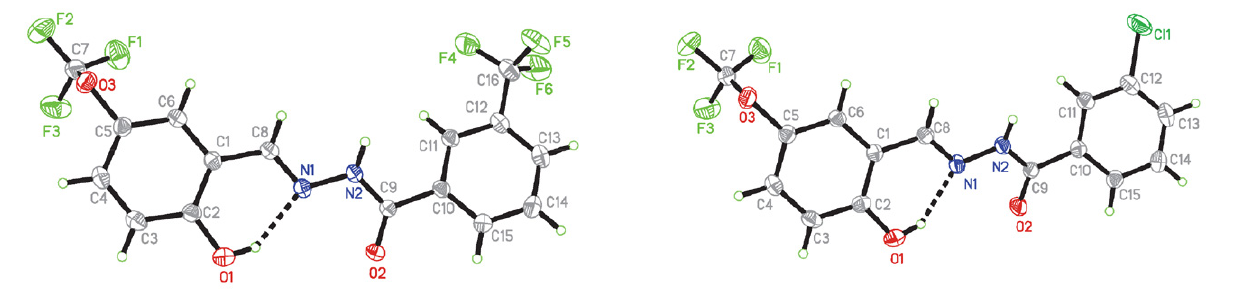
Figure 4. A perspective view of the molecular structure of 4 with the atom labeling scheme. Thermal ellipsoids are drawn at the 30% probability level. Hydrogen bond is shown as a dashed line.